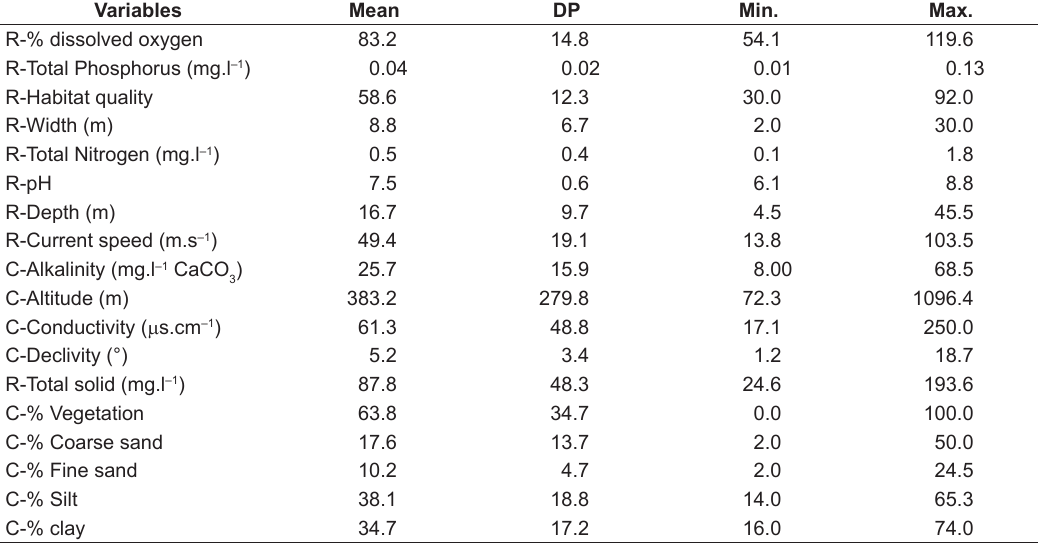
Table 1. Mean, standard deviation, minimum and maximum values for the environmental variables used in the study. R = stream reach variables, C = Catchment